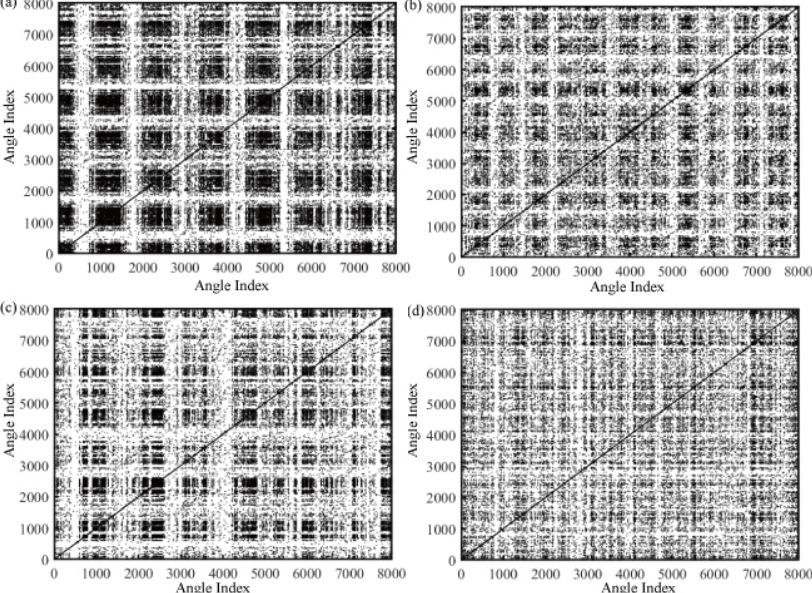
Figure 4. Angular-domain recurrence plots: ( a ) normal ( m = 5, δ = 1, ε = 0.03); ( b ) planet gear-root crack ( m = 3, δ = 1, ε = 0.03); ( c ) sun gear with a tooth-root crack ( m = 6, δ = 2, ε = 0.01); ( d ) planet carrier with crack ( m = 3, δ = 1, ε = 0.03).